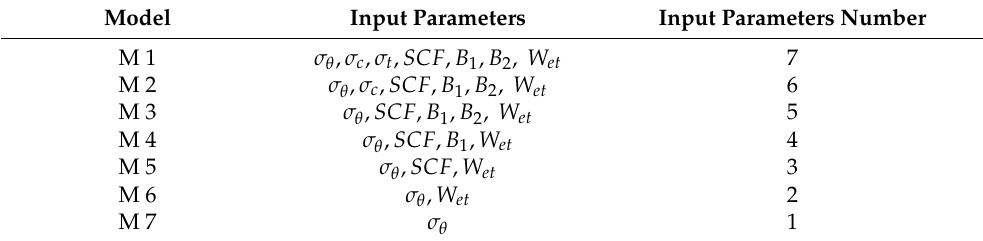
Table 14. Seven models and their input